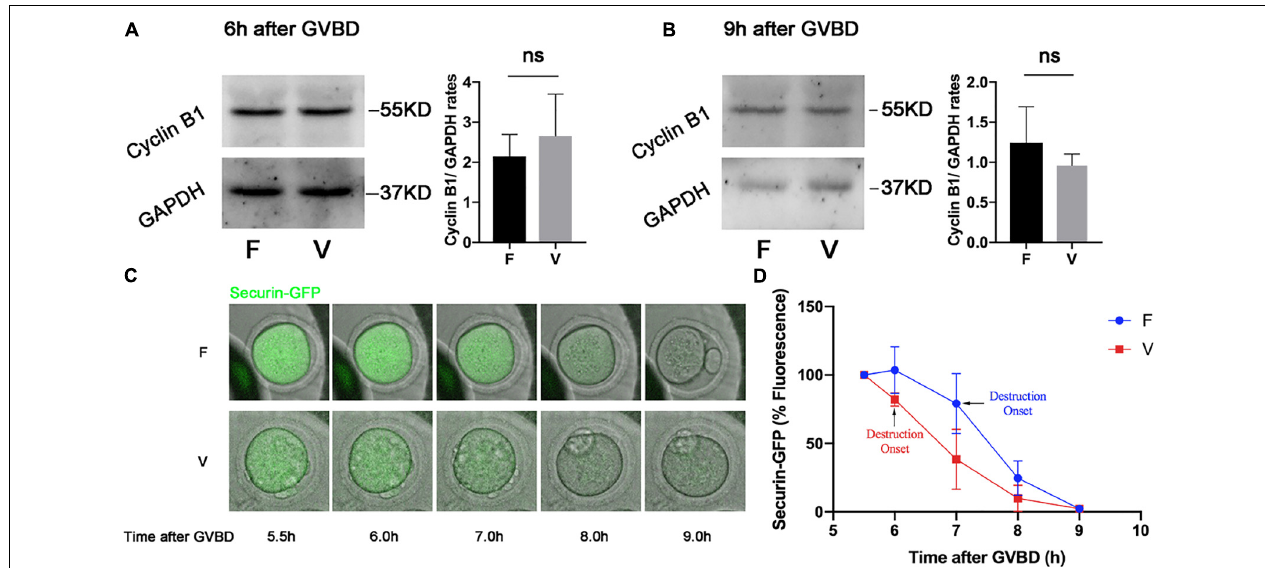
FIGURE 2 | The APC/C activity was not inhibited by vitrification. The protein level of Cyclin B1 were examined by western blot at 6 h (A) and 9 h (B) after GVBD. The experiments were replicated three times. The Cyclin B1 was quantified in both F and V group. (C) . Securin-GFP RNA was injected into GV oocytes, and the fluorescence intensity was monitored during meiosis maturation of oocytes. The image of Securin-GFP signal was acquired by time-lapse fluorescence imaging. (D) The dynamic of Securin-GFP fluorescence was measured from 5.5 to 9 h after GVBD, F: n = 14, V: n = 10; n : the number of oocytes. The experiments were replicated three